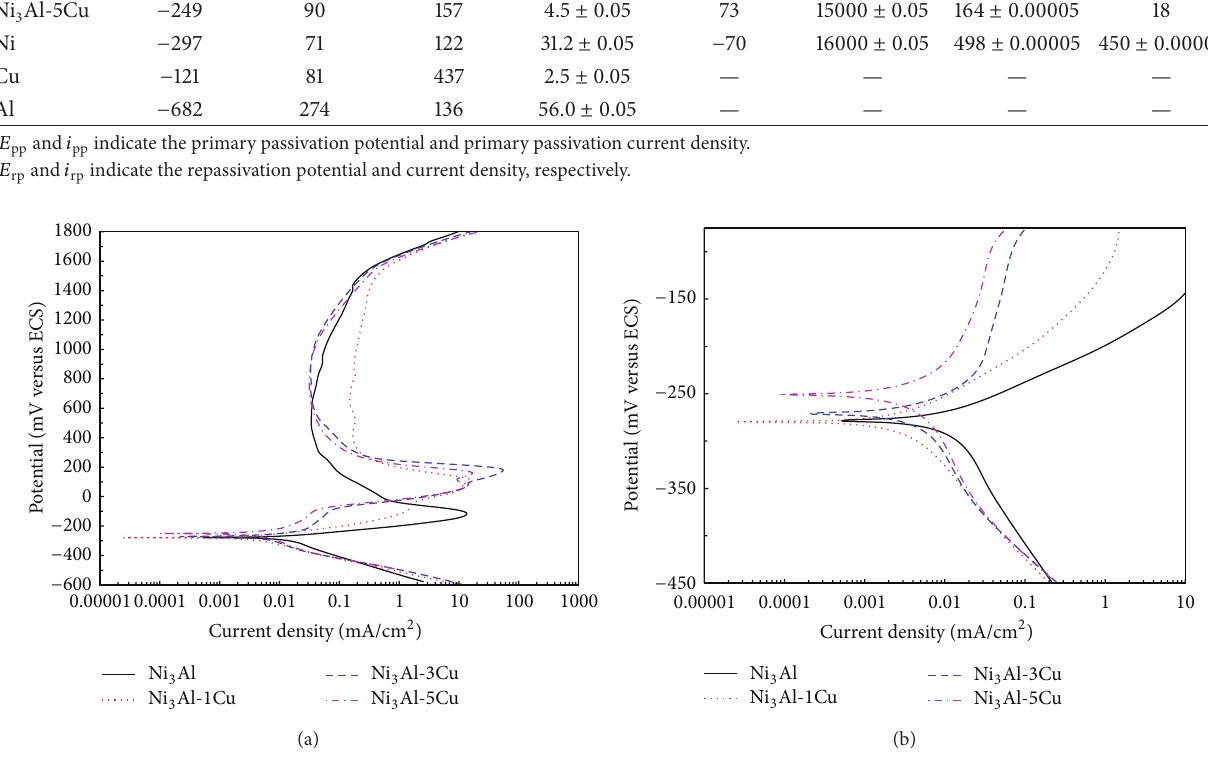
Figure 1: Polarization curves of the Ni 3 Al- 𝑥 Cu intermetallic compounds tested in a 1.0 M H 2 SO 4 solution at 25 ∘ C.